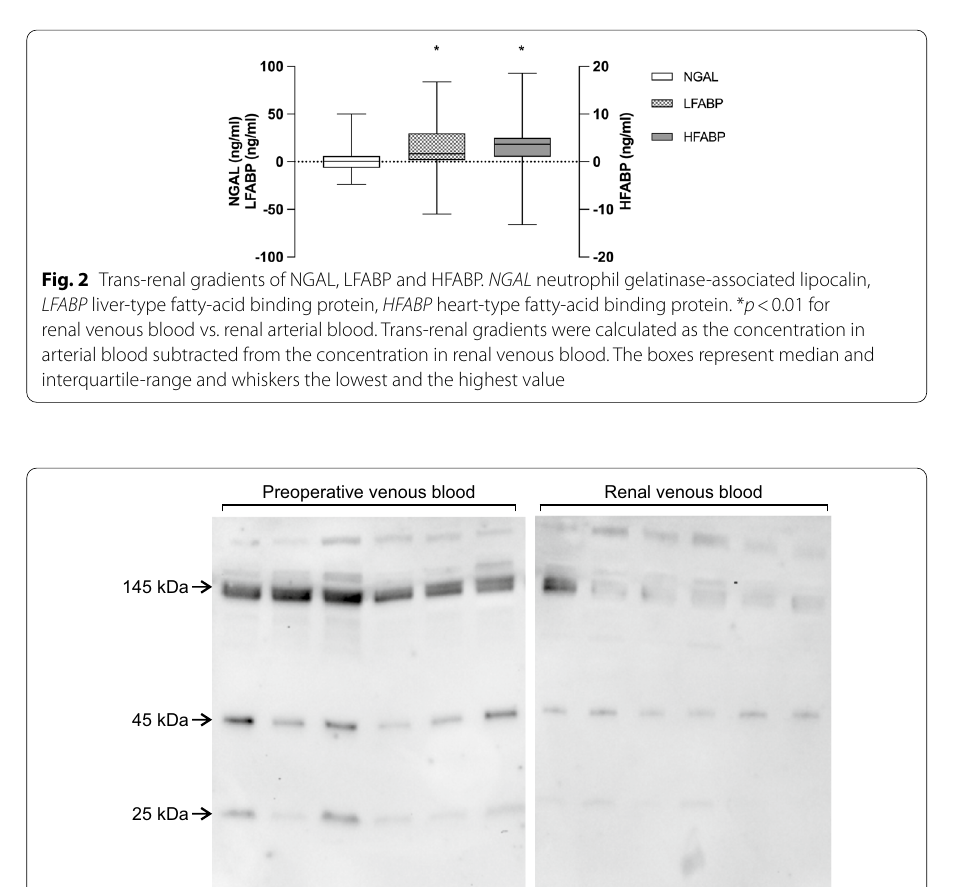
Table 4 Quantification of NGAL isomers by Western blotting